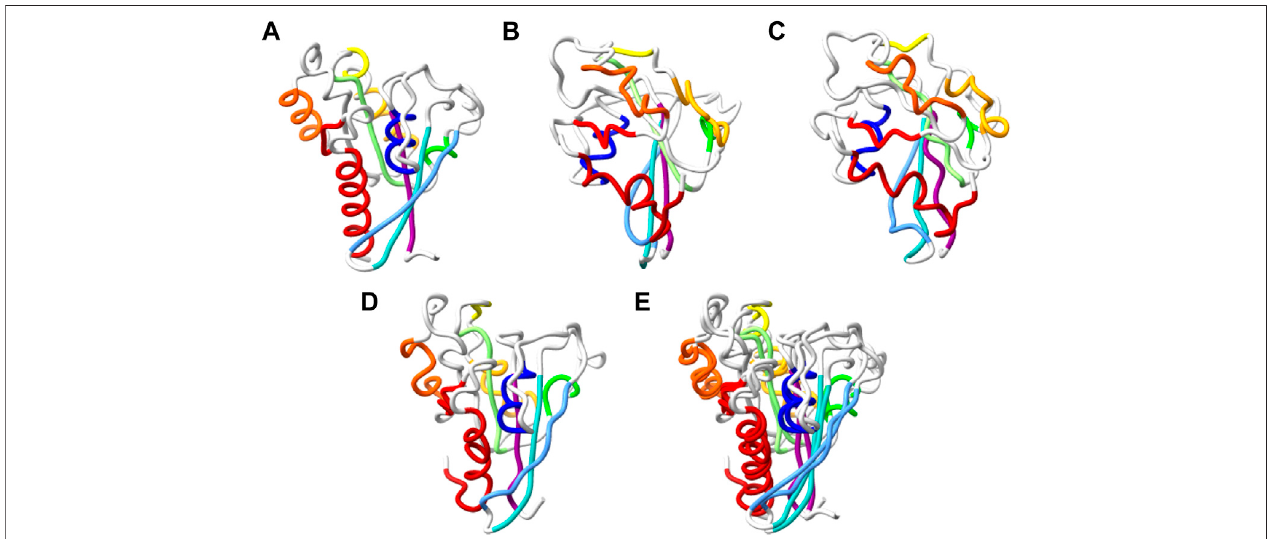
FIGURE5| Reconstructionofchirallyaccuratefullatommodel. (A – D) .Alphatracerepresentationof:thenativestructureofT0798 (A) ,MimNetoutputwithdRMSD 5.194Å, GDTTS 0.19, LDDT 0.424 (B) , and two energy minimize models of the MimNet output (C) and its mirror image (D) . The secondary structure elements of the native structure are colored from fi rst (dark blue) to last (dark red). The atoms of the other models are colored the same, regardless of their conformation. The energy of the minimized model (C) is − 7838 (arbitrary units) and a dRMSD/GDTTS/LDDT of 5.076Å/0.20/0.426, while the energy of the minimized mirror image (D) is − 18474, and a dRMSD/GDTTS/LDDT of 4.866Å/0.57/0.4358. (E) . A ribbon representation of minimized mirror image, superimposed on the native